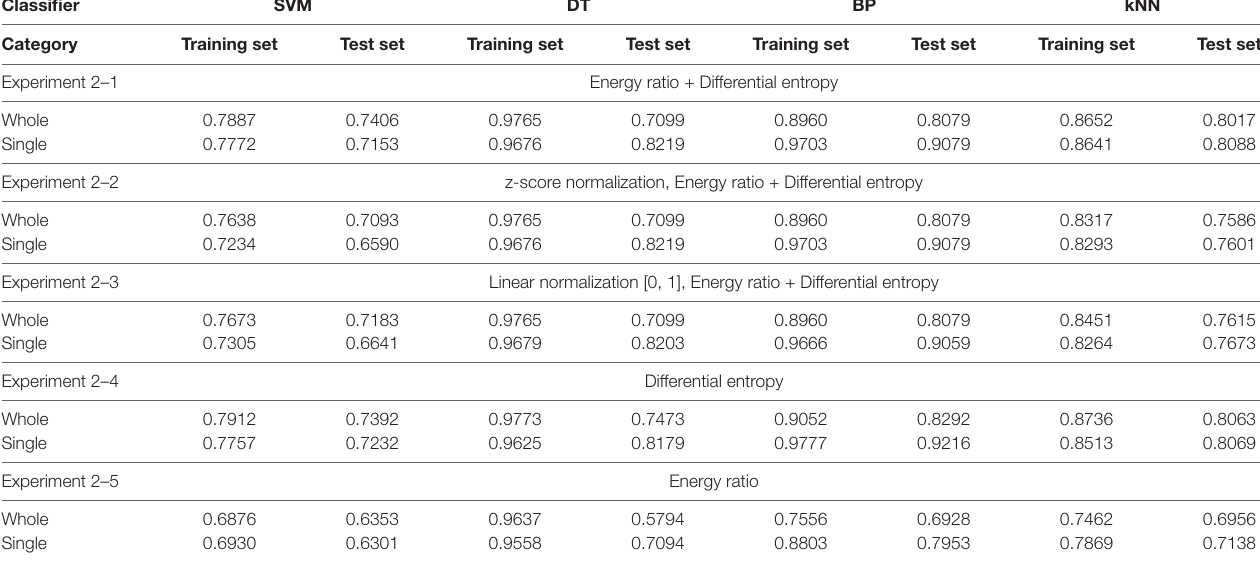
TABLE 3 | Effect of energy proportion and differential entropy on emotion